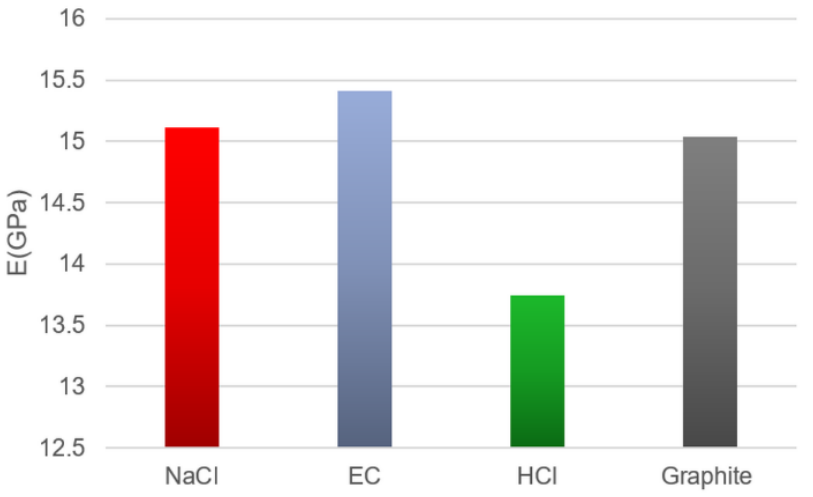
Figure 6. Young’s modulus of free-standing YSZ coatings determined by three-point bending experiments. See Table 1 for the details of different substrate removal methods.